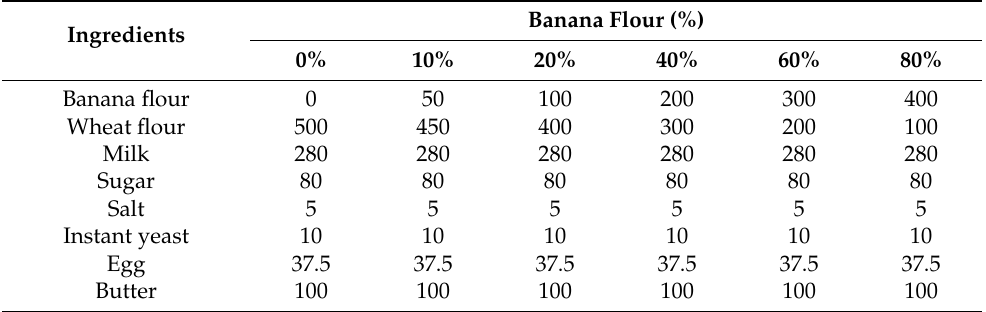
Table 5. Formulation of bread making with different amounts of wheat and unripe banana